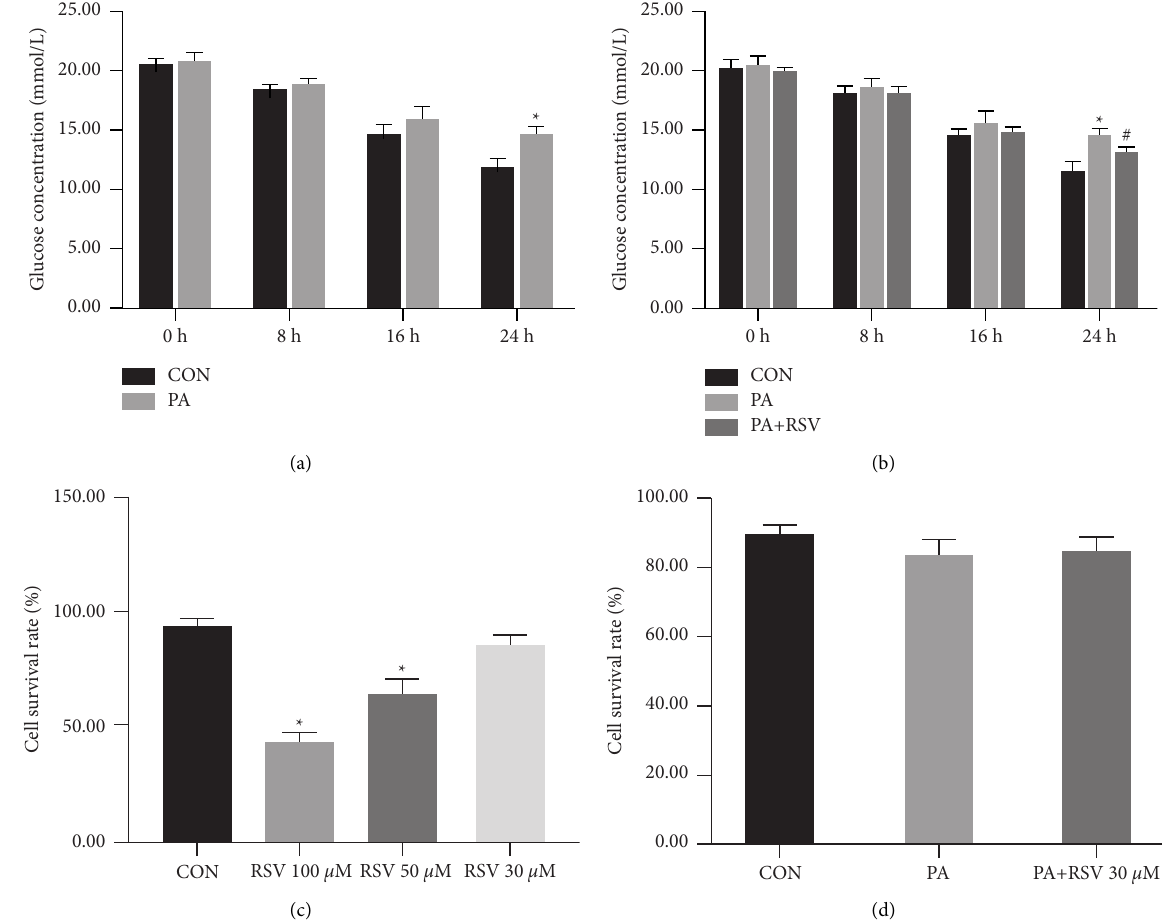
Figure 5: Resveratrol reduced PA-induced glucose concentration in vitro . Glucose concentration in the medium after 0, 8, 16, and 24h treatment with PA (a) and treatment with PA and RSV (b). Cell survival rate after 24h treatment with different concentrations of RSV (c) or PA and RSV treatments (d). Data are shown as the mean ± SD ( n � 6). ∗ P < 0 . 05 versus CON; # P < 0 . 05 versus